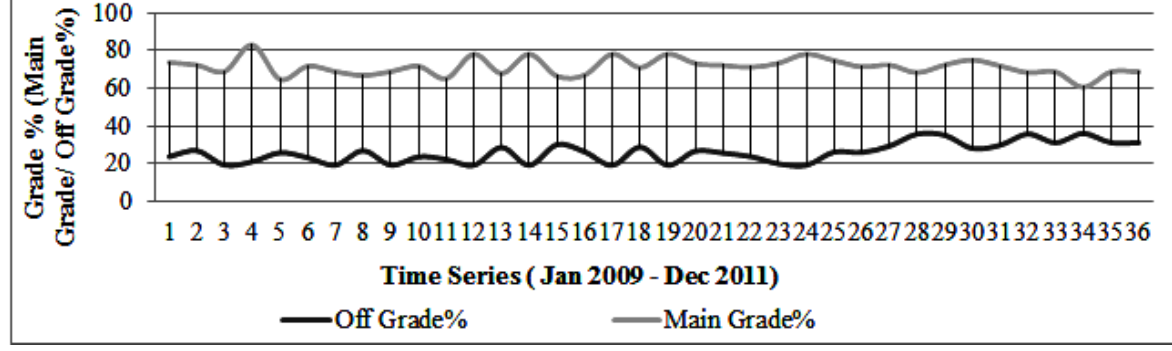
Fig 4: Main Grade and Off Grade Percentages maintained in Three Year Green Leaf Supply